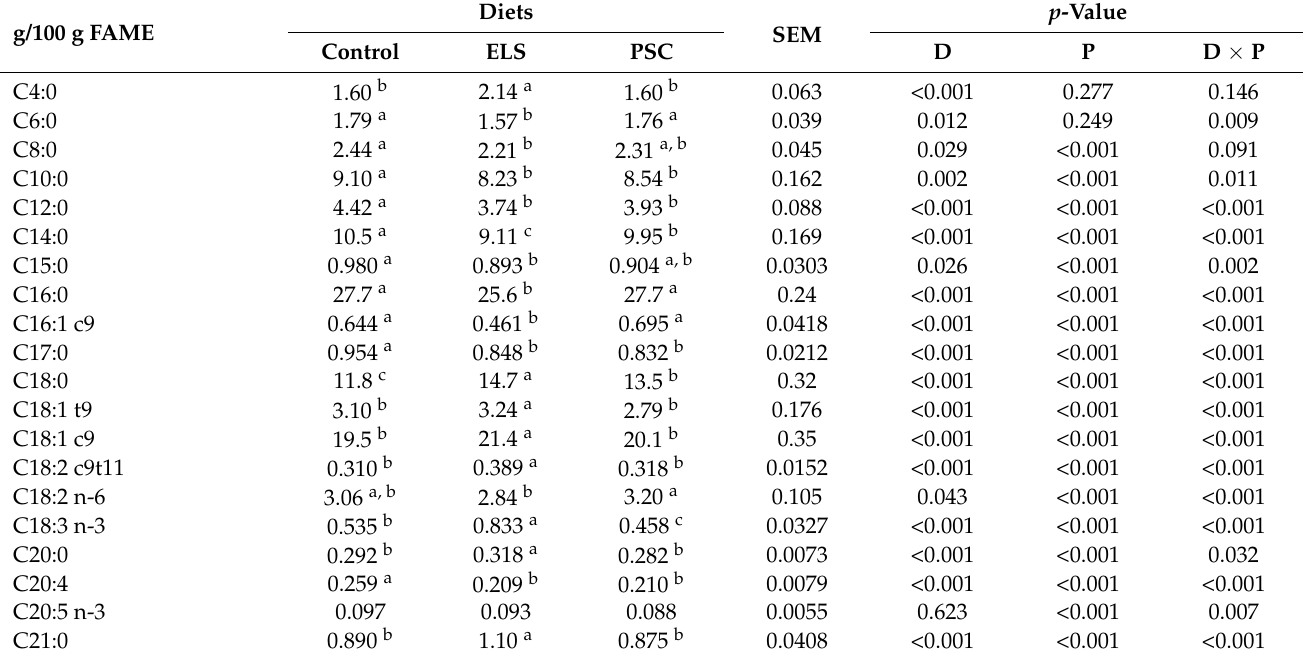
Table 3. Mean values of fatty acid proportions (g/100 g fatty acids) of semi-hard cheese made of milk from goats fed with diets containing extruded linseed (ELS) or pumpkin seed cake